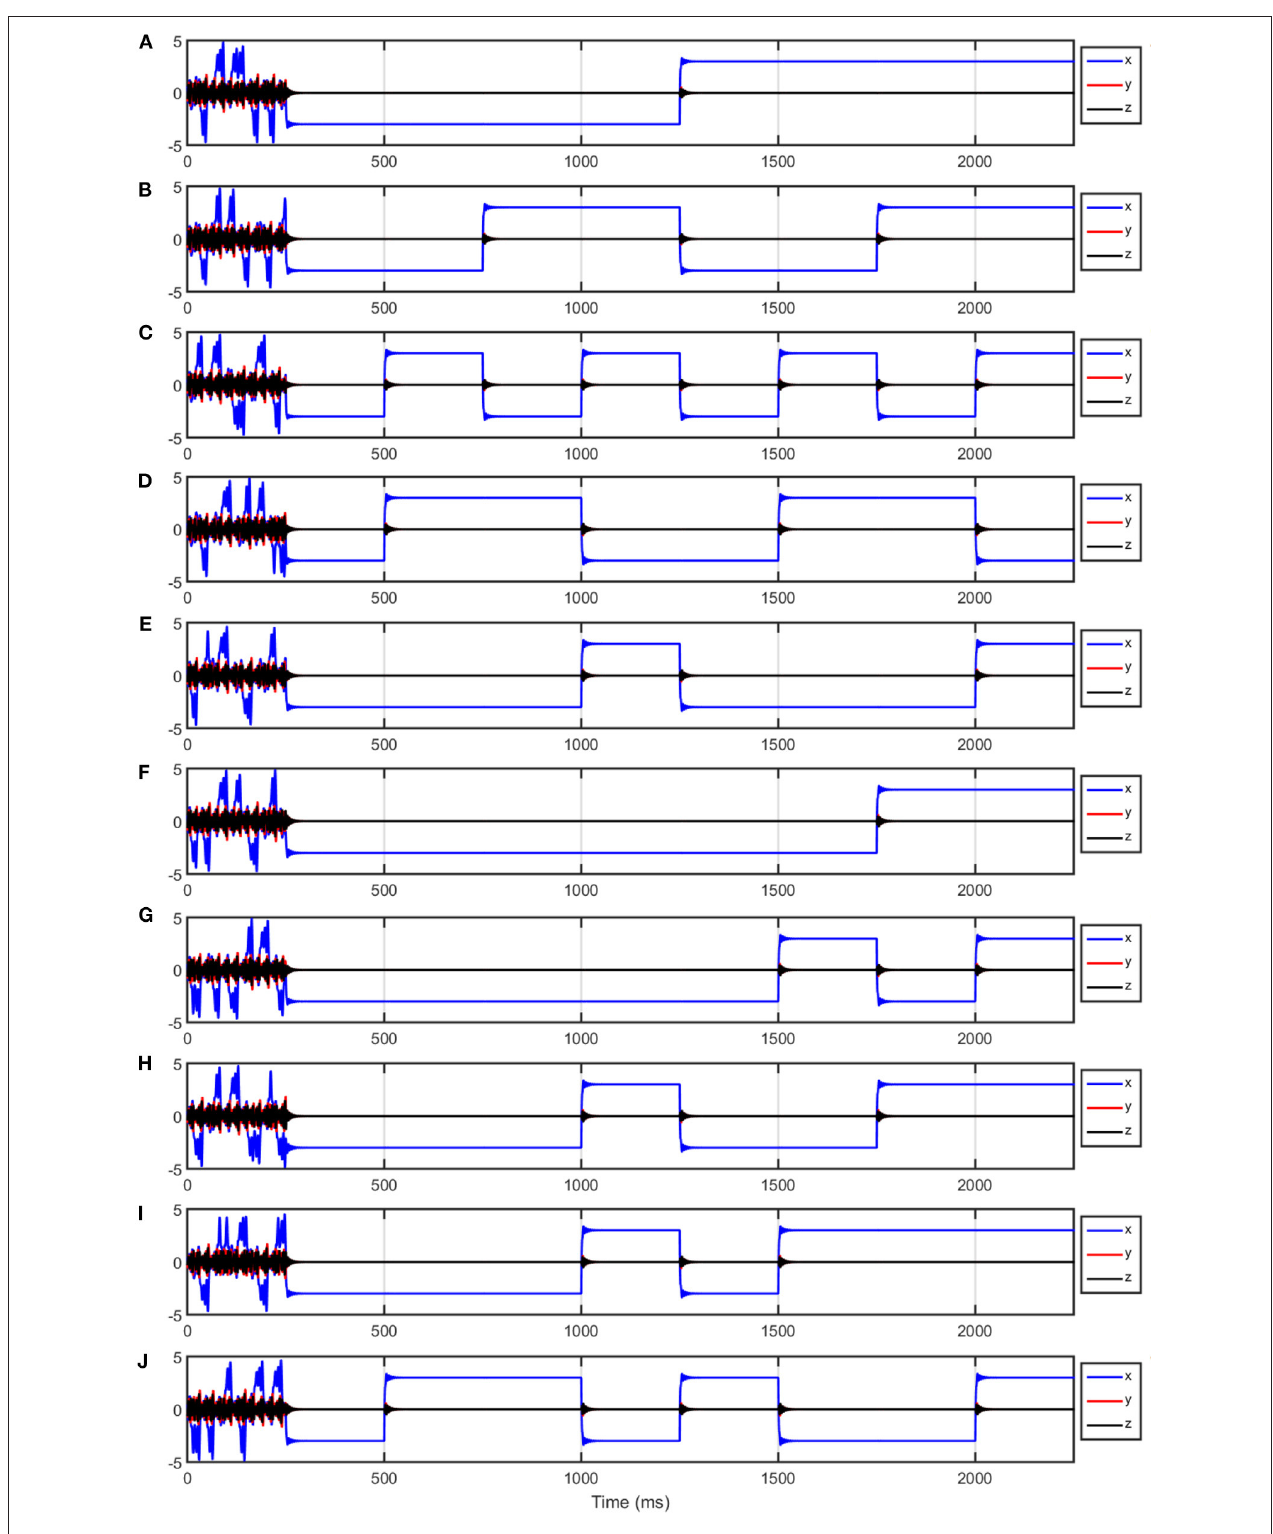
FIGURE 8 | Temporal evolution of the nodes in the full adder. The plot (A) corresponds to C in ; (B) to I 1 ; (C) to I 2 ; (D) to G 1 ; (E) to G 2 ; (F) to G 3 ; (G) to G 4 ; (H) to G 5 ; (I) to G 6 which is C out ; and (J) to G 7 which is the sum